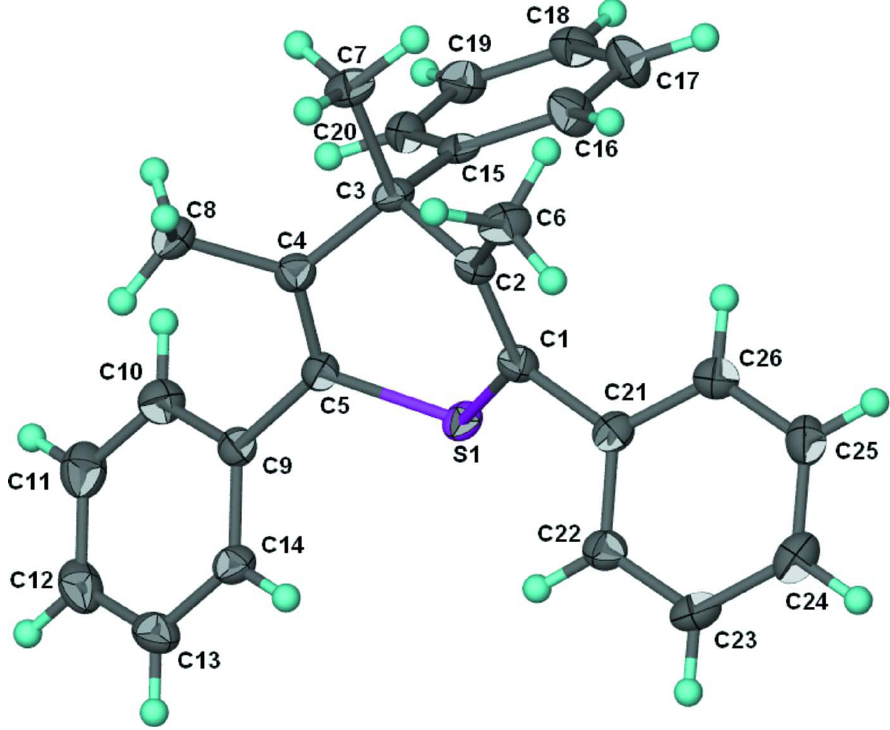
Figure 1 Thermal ellisoid plot (Barbour, 2001) of C arbitrary